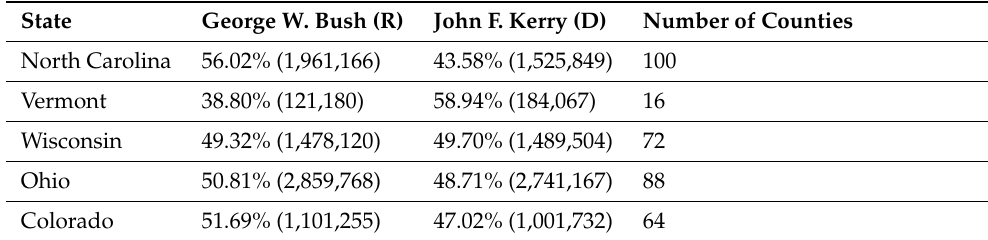
Table 5. States from 2004 US Presidential Election used for Analysis.